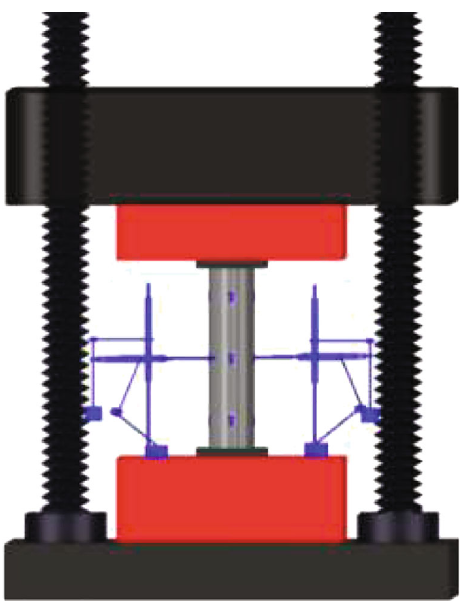
Figure 2: Specimen loading